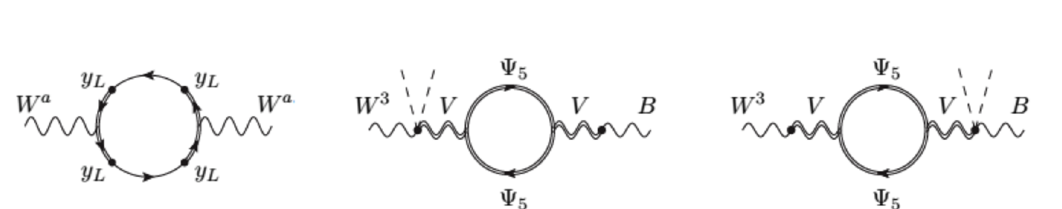
Figure 1 . Radiative contributions to the T parameter (left panel diagram) and the S parameter (middle and right panel diagrams). The straight and wavy double lines represent, respectively, the top-partner spurions and the composite spin-1